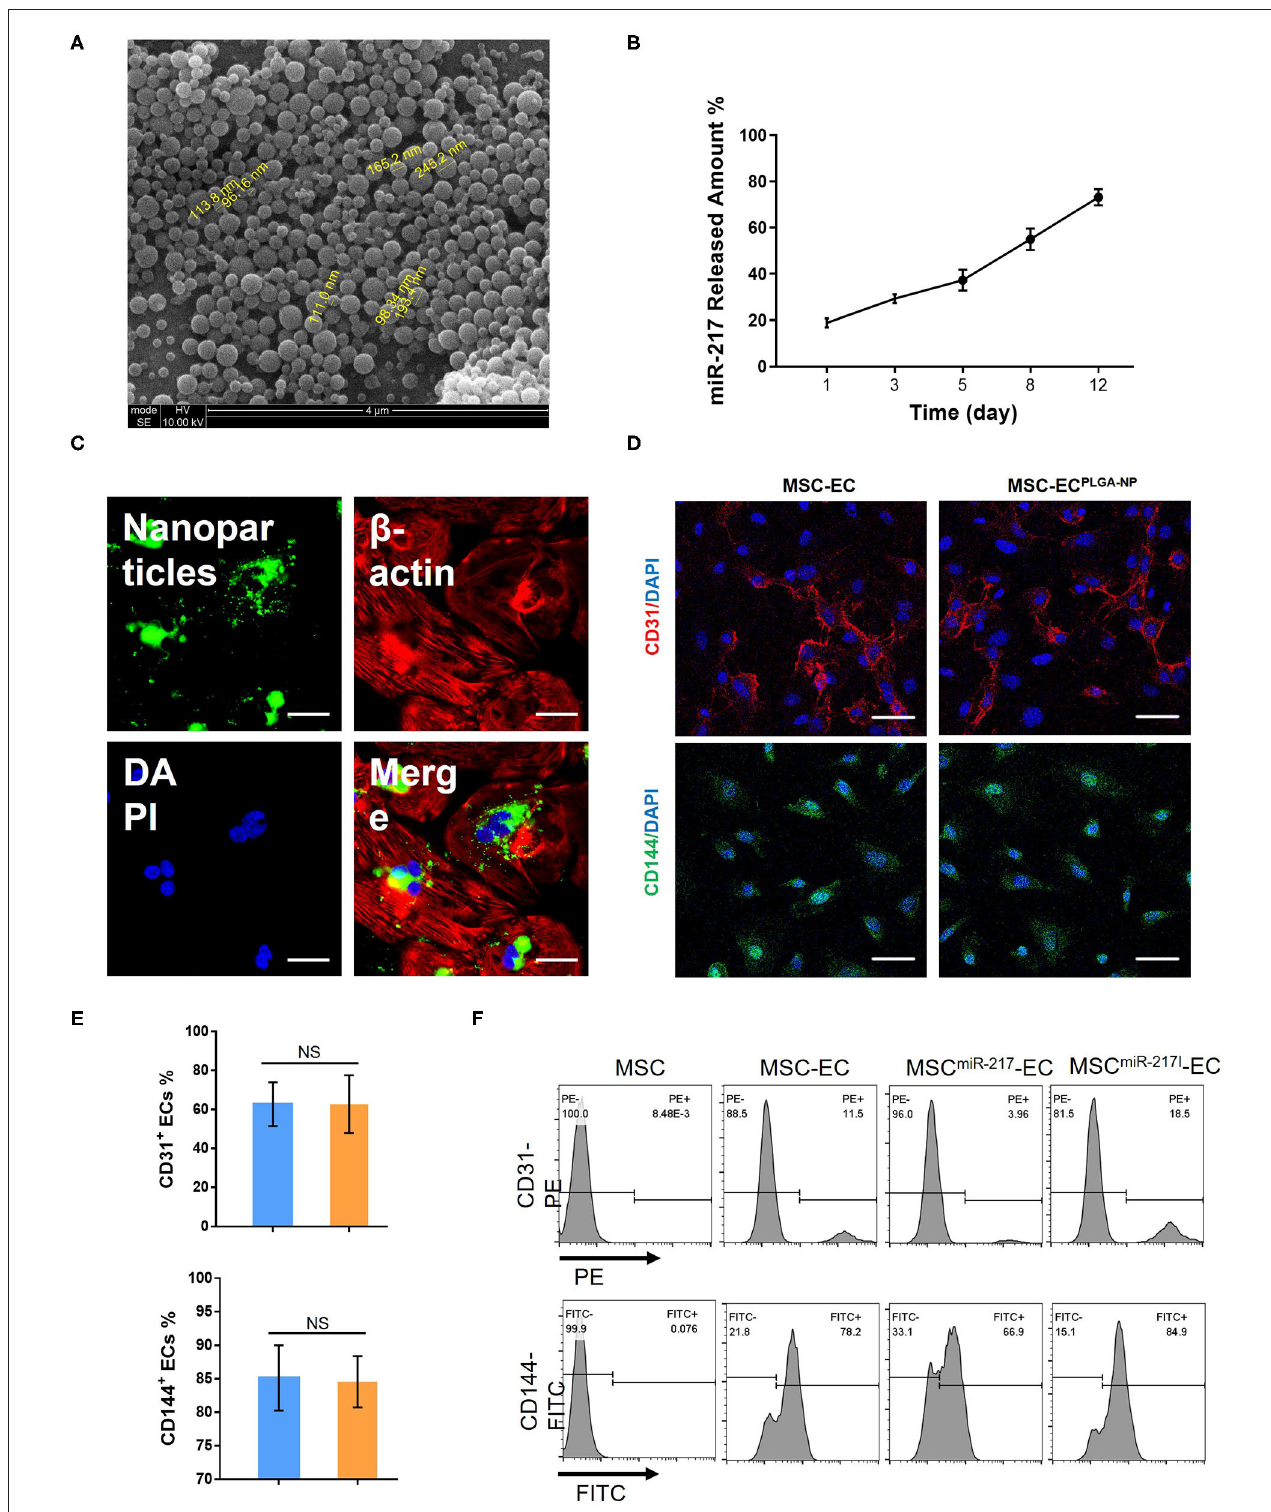
FIGURE 1 | Characterization of PLGA-NP and evaluation of miR-217 effect on endothelial cells (EC) differentiation from MSC. (A) PLGA-NP image under a scanning electron microscopy. (B) The cumulative amount of miR-217 released from the PLGA-NP was determined via qPCR. (C) Representative image of MSC after 12h